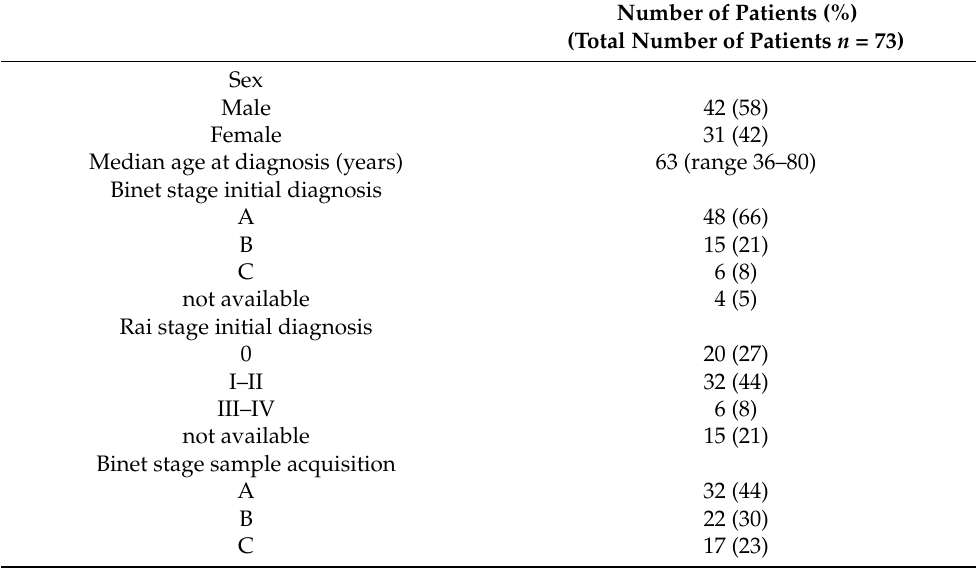
Table 1. Patient